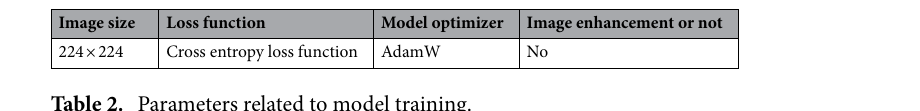
Table 2. Parameters related to model